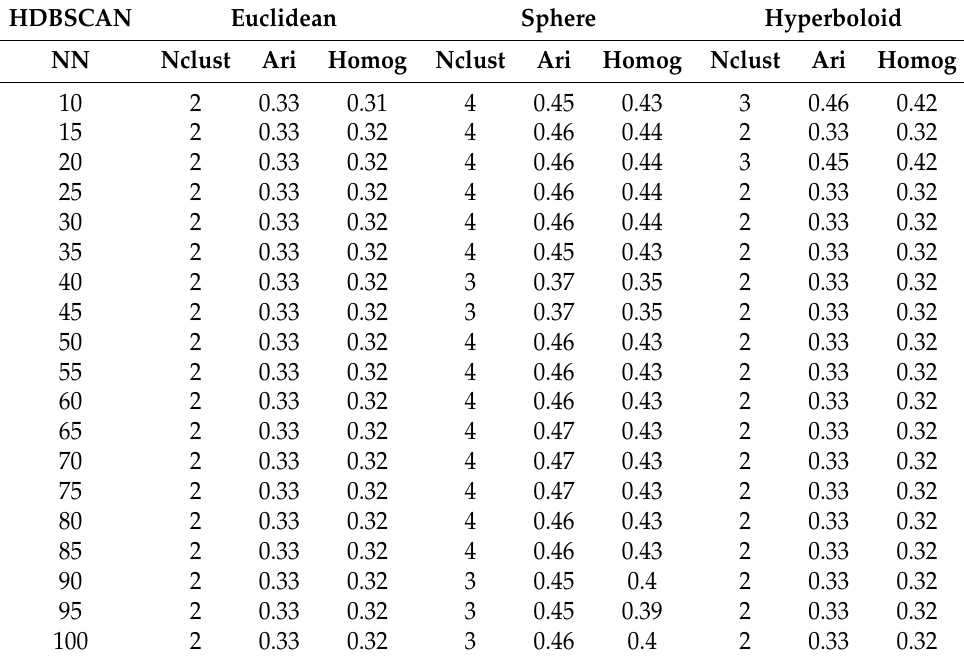
Table A2. Comparison of clustering performances. N c , ARI, and homogeneity score estimated for each NN and latent space (spherical, Euclidean, hyperbolic) for HDBSCAN and DBSCAN cluster- ing